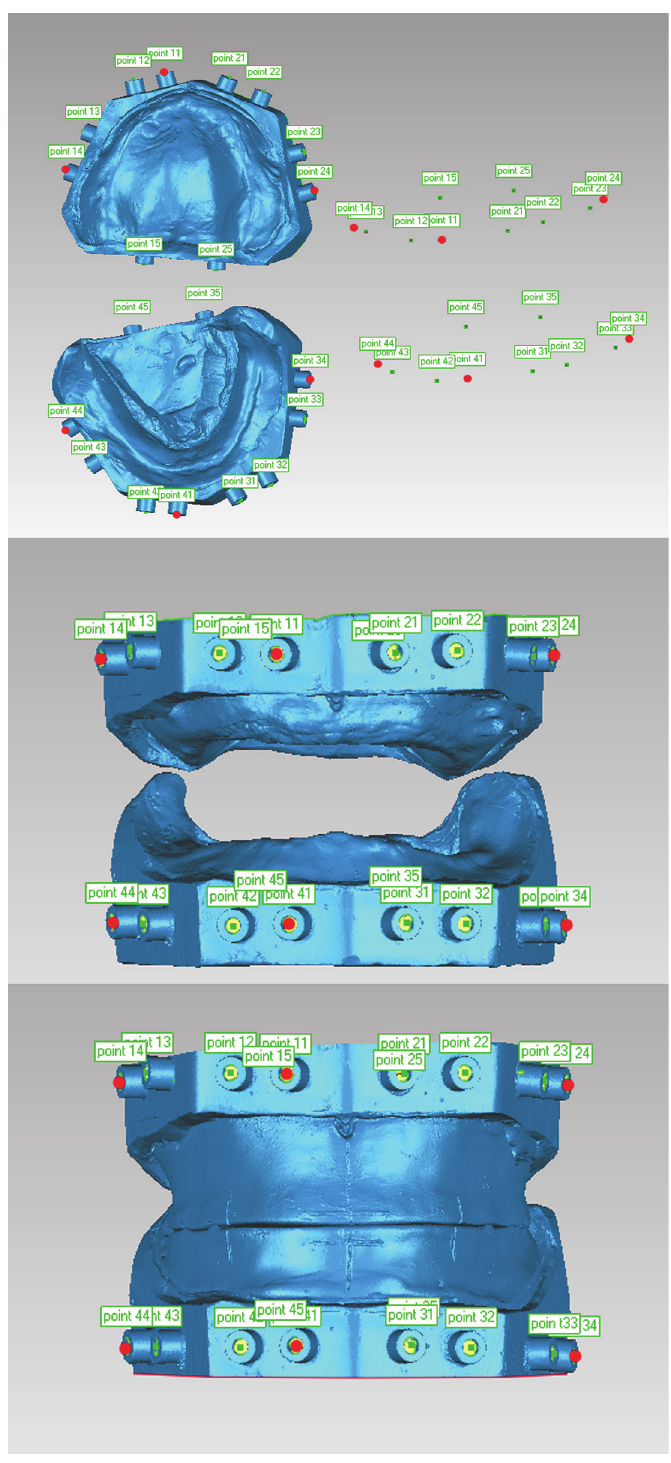
Fig 3. Registration of mark points for upper and lower edentulous jaw models and dentures using the RPS registration command.